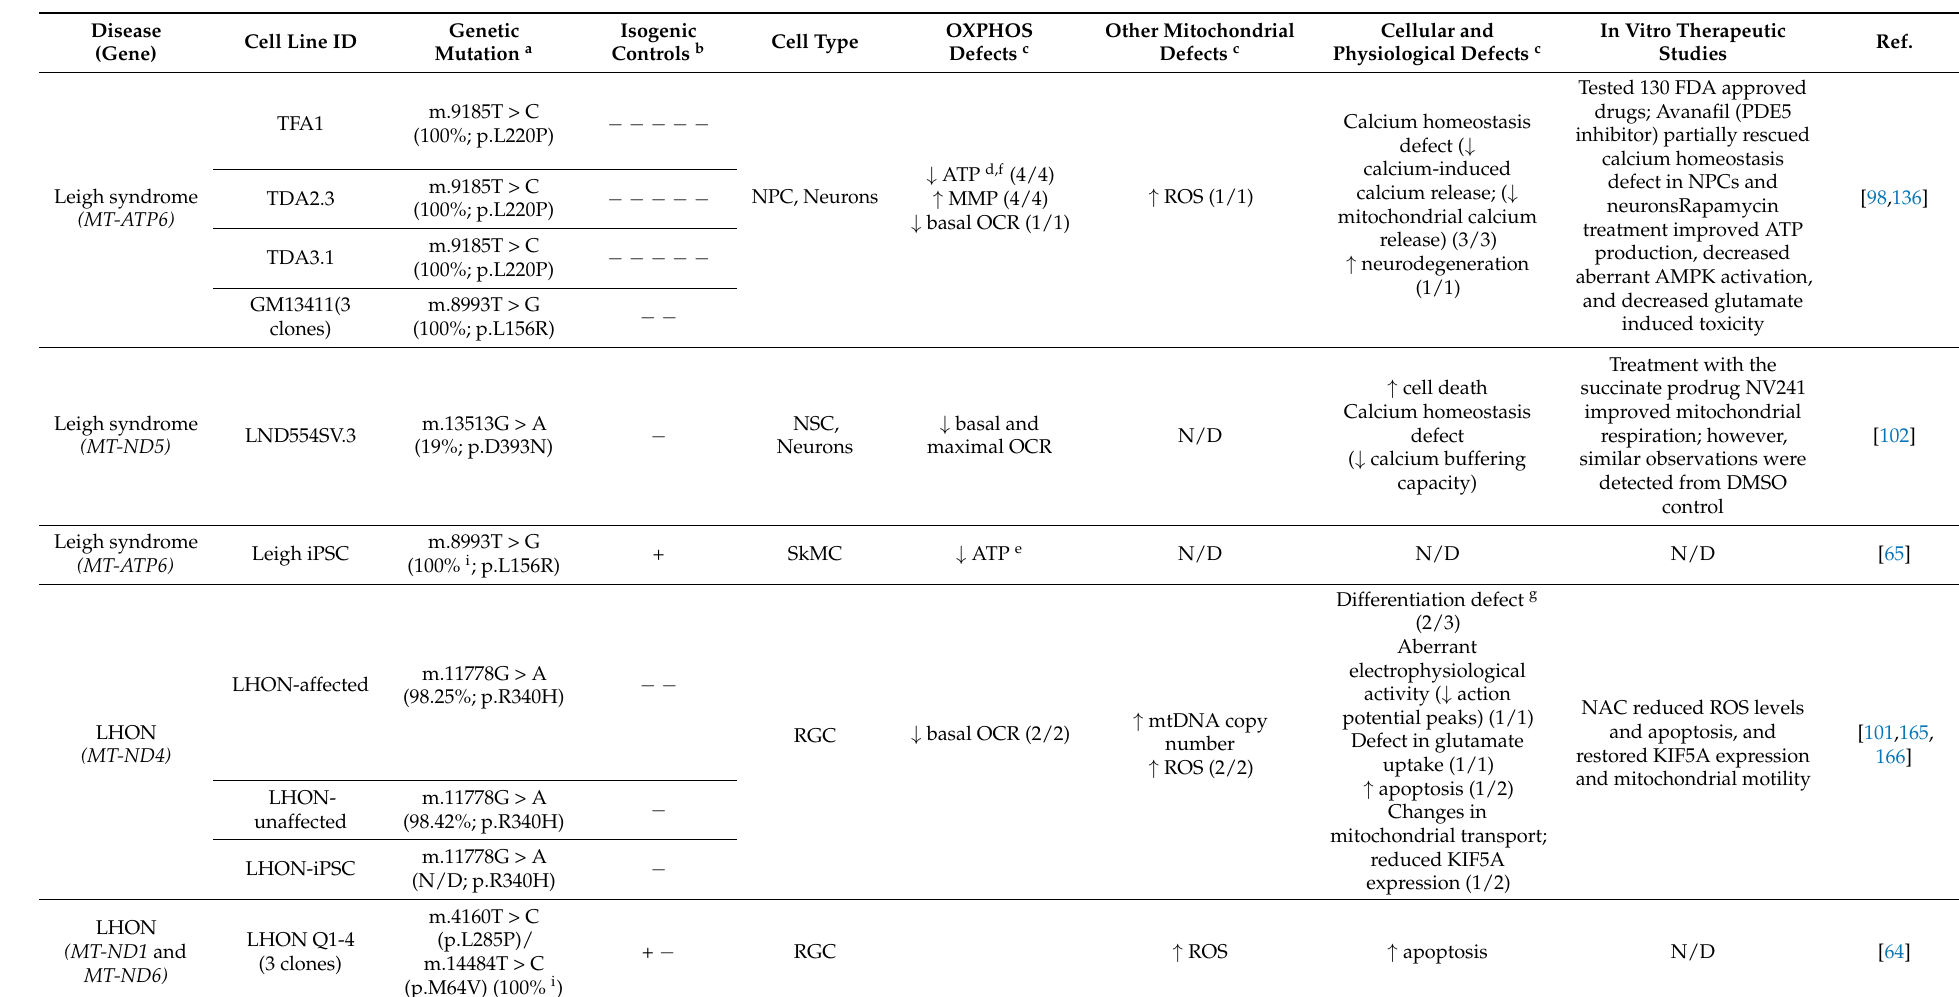
Table A4. Functional defects of hPSC-derived clinically relevant cell types of mtDNA associated mitochondrial